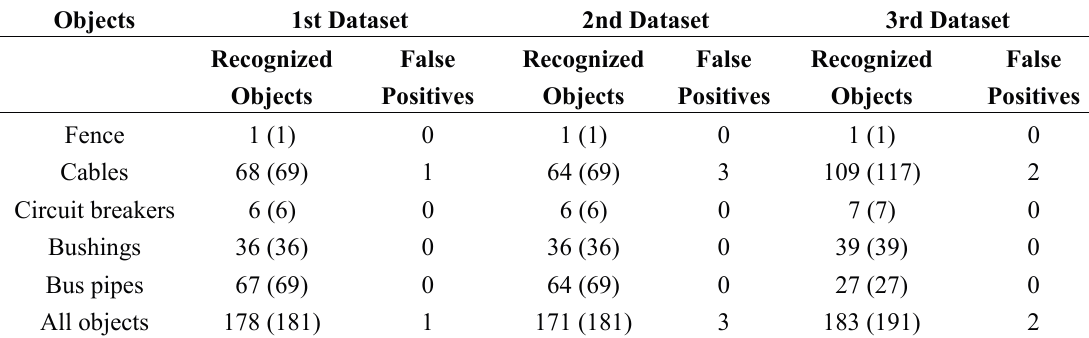
Table 5. Recognition results at object